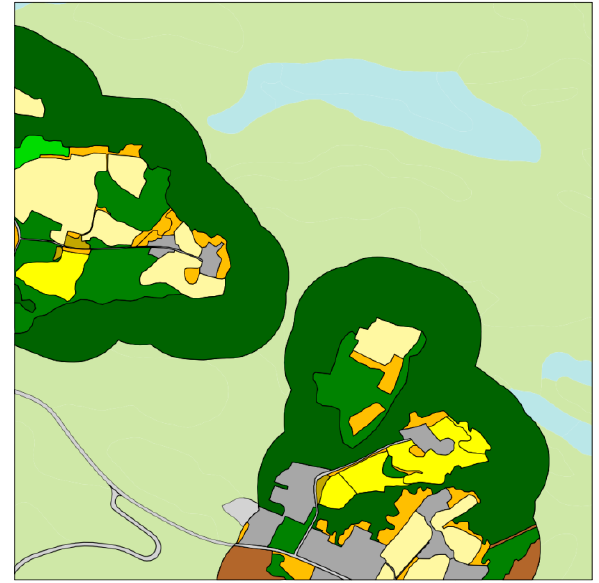
Figure 2. Example of detailed 3Q-mapping of agricultural land (yellow) and surrounding 100 m wide buffer zone (grey built-up land, green forest, brown clear-fell). Outside the buffer zone, data are acquired from Area Resource Maps (AR5).